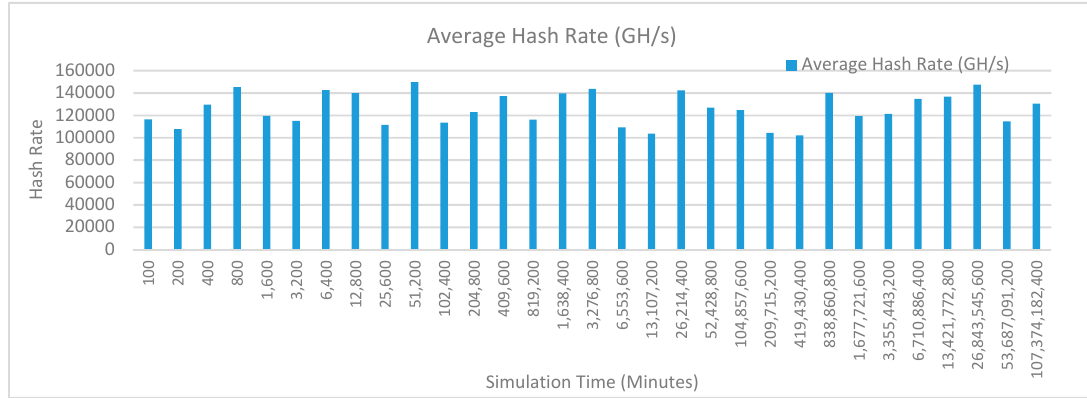
Figure 17. Average hash rate analysis (with IoT, edge, fog, and cloud).